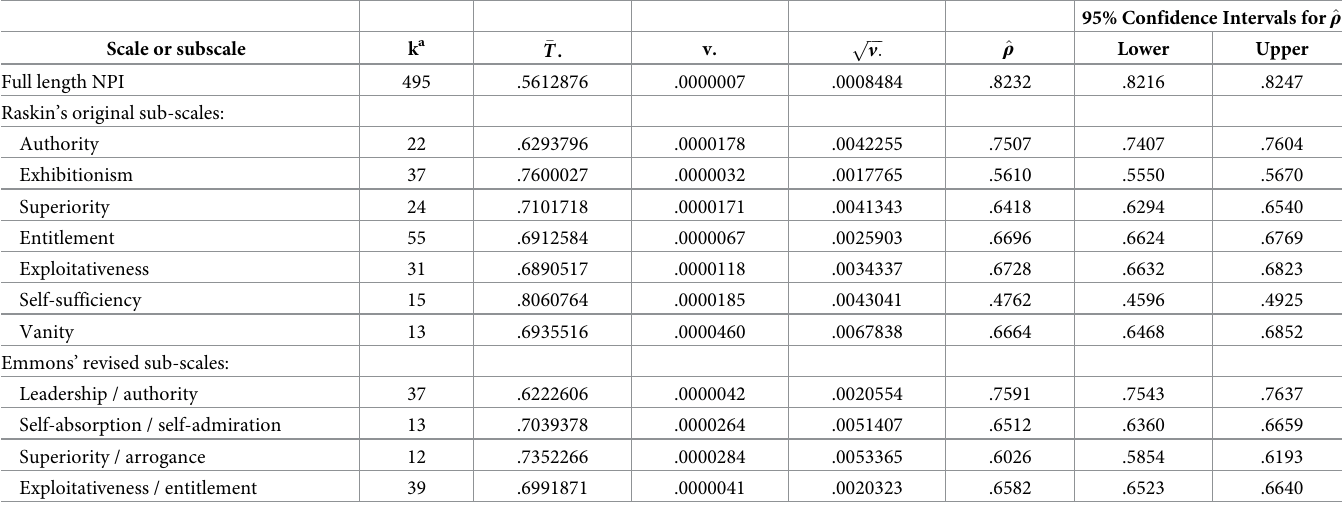
Table 3. Meta-analytic results for NPI and its